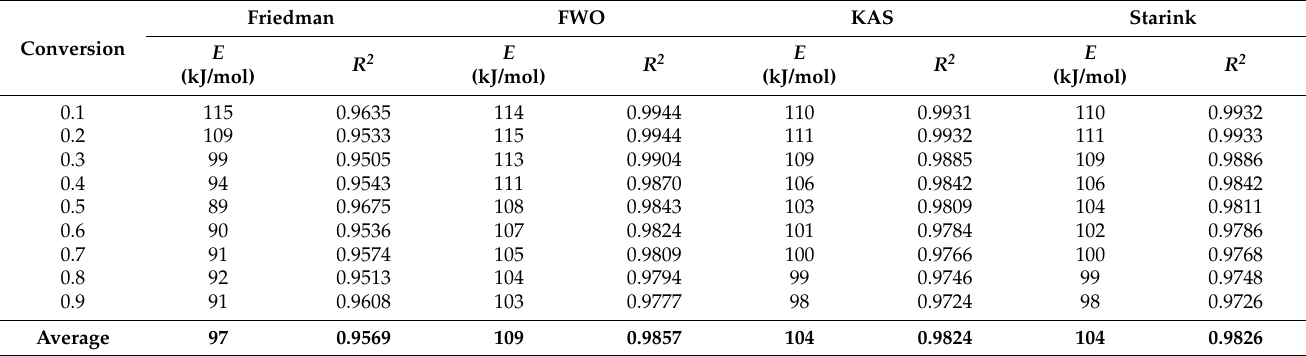
Table 8. Activation energy of PLA pyrolysis obtained from isoconversional